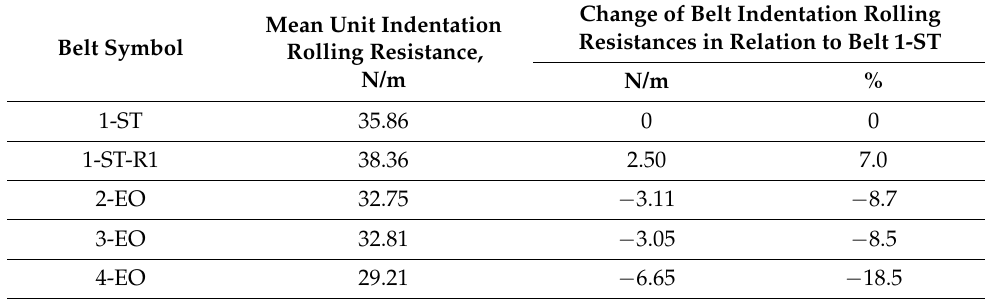
Table 6. Test results